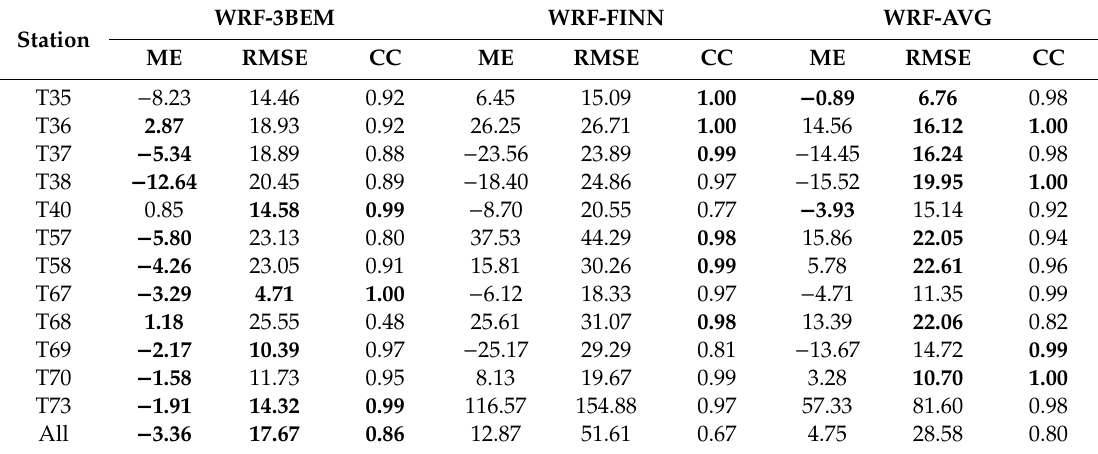
Table 8. MEs (E[simulations-measurements]), RMSEs, and CCs of simulations and measurements for